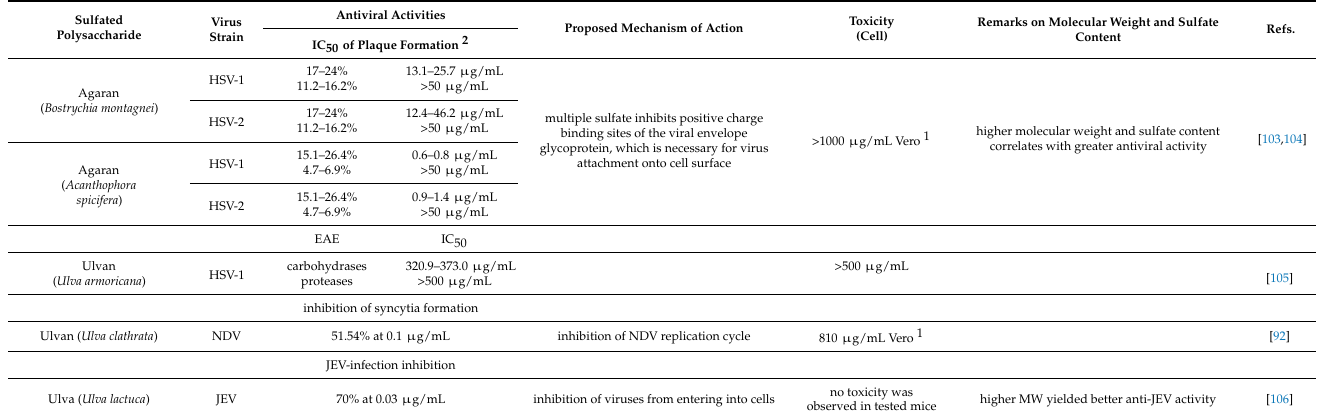
Table 5. Summary of antiviral activity among various agaran and ulvan, with each respective proposed mechanism of action and remarks on molecular weight and sulfate content of the tested